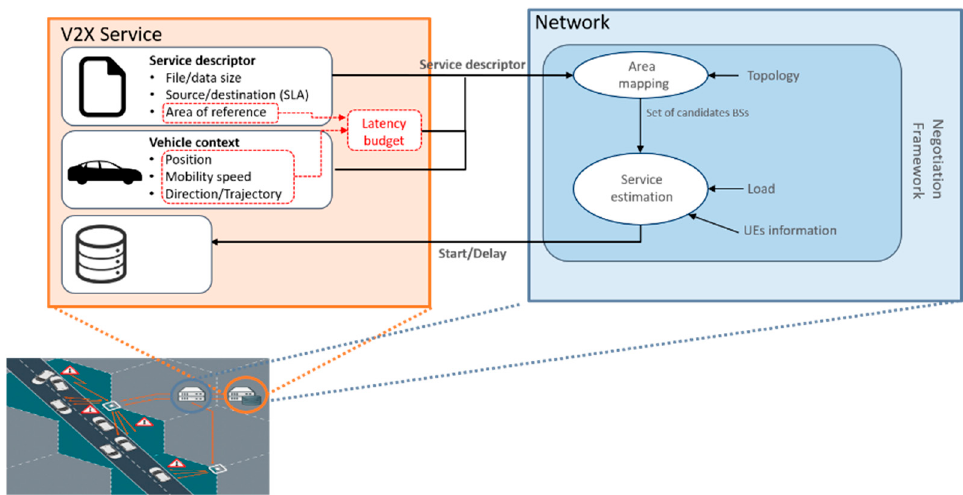
Figure 7. An example of a V2X service negotiation applied to a file transfer service.